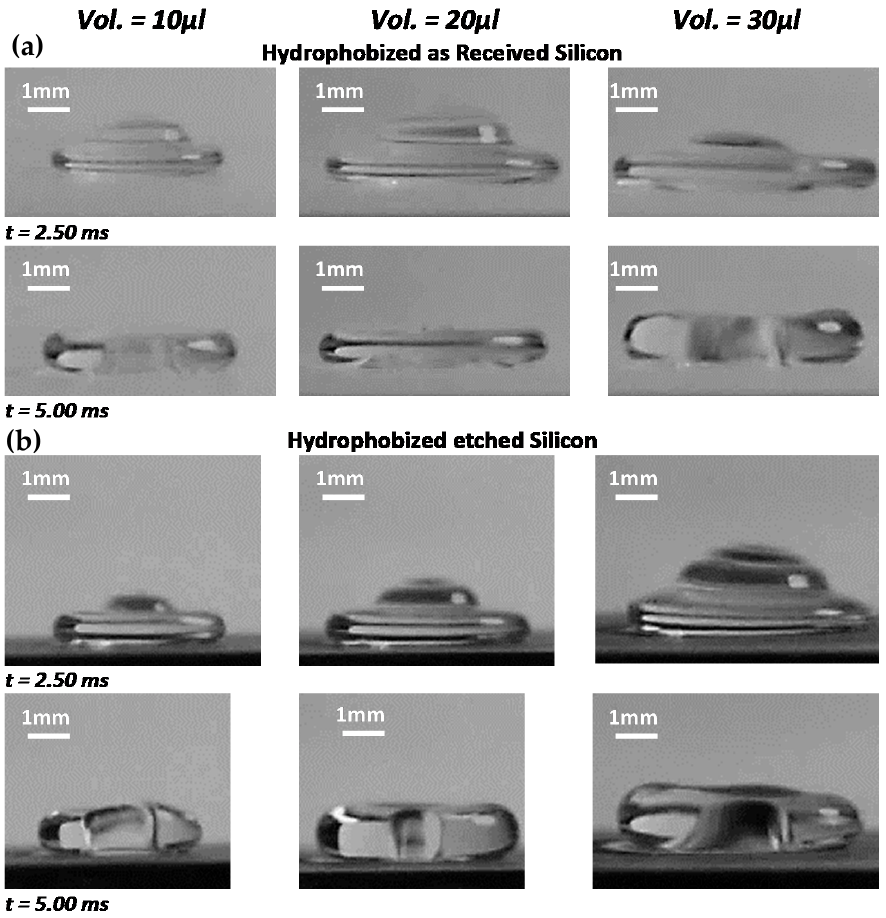
Figure 5. High-speed camera images of impacting droplet at different transitions on the impacted surface for ( a ) hydrophobized etched and ( b ) hydrophobized as-received silicon wafer. The droplet impact height is 20 mm.